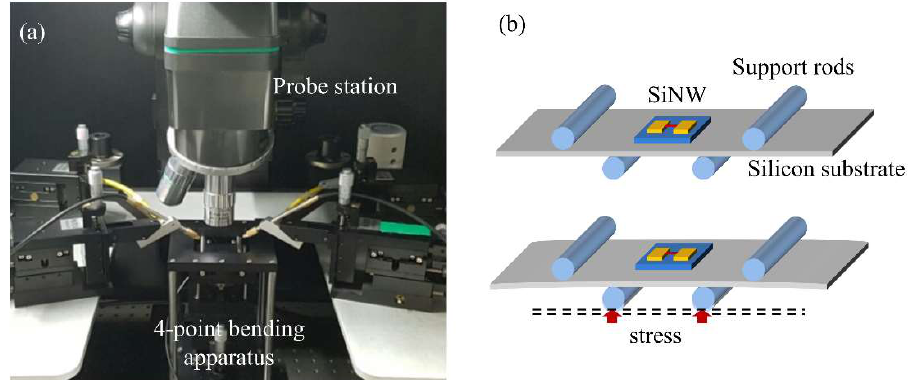
Figure 5. Experimental setup. ( a ) Equipment for measuring the PZR effects of the SiNWs. ( b ) Schematic configuration used for four-point bending method (figure is not drawn to scale).